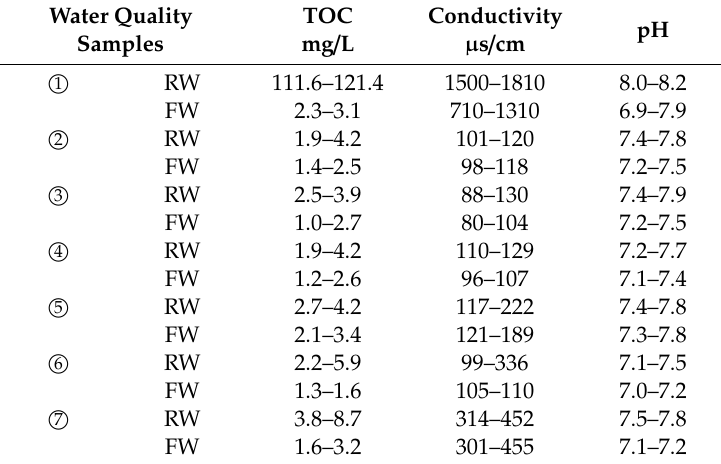
Table 1. Water quality of sampled waters.